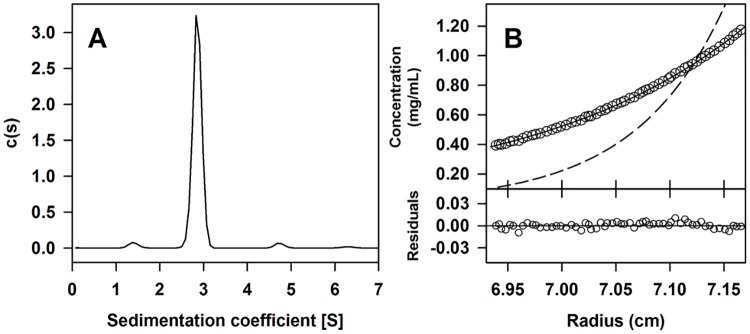
Analytical ultracentrifugation analyses showed that RelLS20 is monomeric in solution.Purified RelLS20 (12 μM) was studied by sedimentation velocity (SV) and sedimentation equilibrium (SE). Plot (A) represents the sedimentation coefficient distribution c(s) profile obtained by SV data analysis. Graph (B) shows the experimental data obtained by SE assays (empty circles) and best-fit analysis considering a protein monomer (black line) and dimer (dashed line) species model. Lower part represents the difference between experimental data and the best fit to a single species model (residuals).